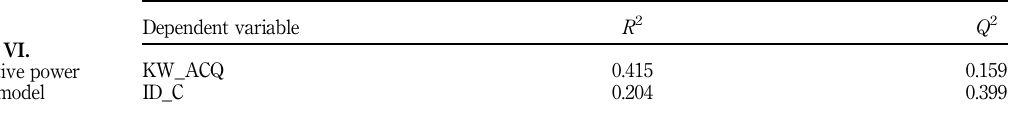
Table VI. Predictive power of the